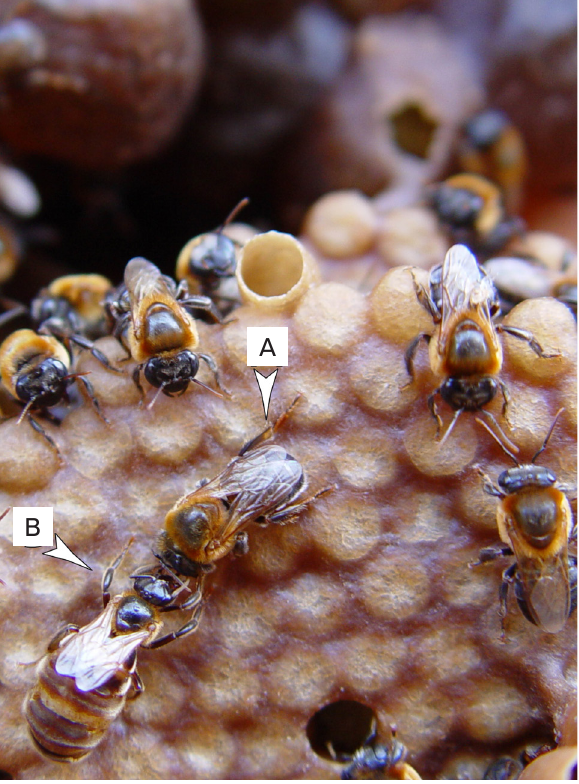
Figura 2. (A) Uma operária; (B) alimentando a rainha da colmeia (Fonte: José Maria Vieira